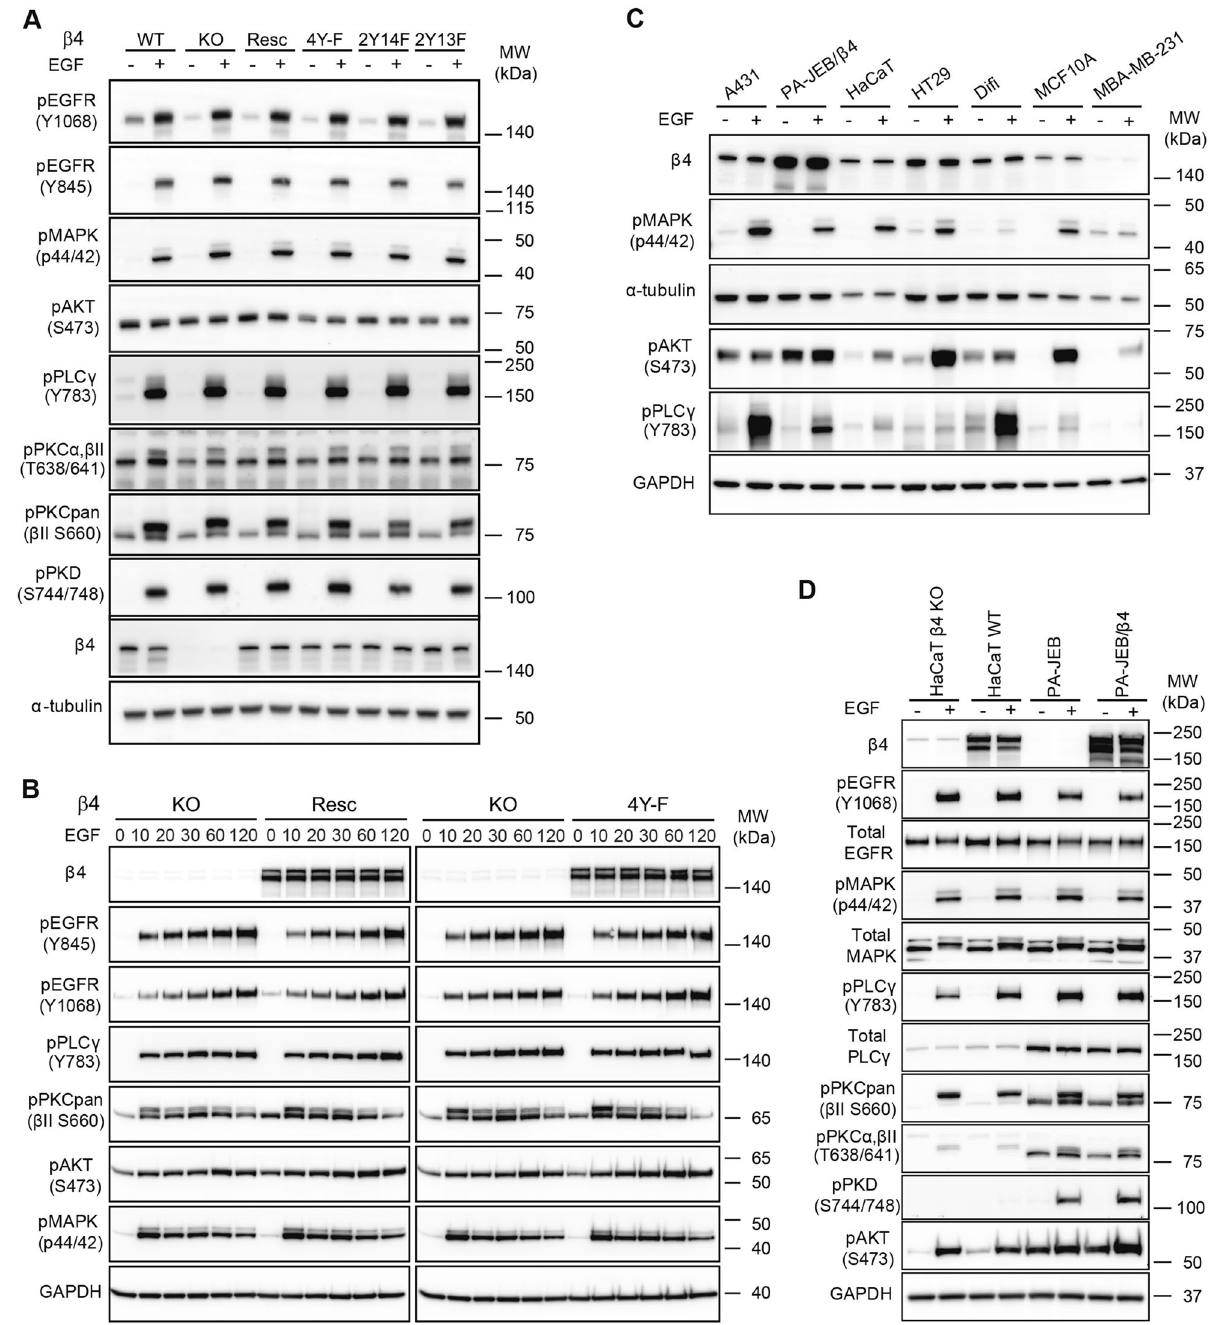
Figure 5. β4 and its tyrosine phosphorylation at the CS does not alter signaling downstream of the EGFR. ( A ) Western blot analyses of WCLs from various WT and β4 mutant A431 cell lines, untreated or treated for 5 min with EGF after 20 h serum starvation, for pEGFR (Y845 and Y1068), pMAPK, pAKT, pPLCγ1, pPKCα, βII (T638/641), pPKCpan (βII S660), pPKD (S744/748), β4 and α-tubulin (loading control). ( B ) Western blot analyses of A431 β4 (Resc), β4 (KO) and β4 (4Y-F) cells untreated or treated for different timepoints (0, 10, 20, 30, 60 and 120 min) with EGF after 20 h serum starvation, for β4, pEGFR (Y845 and Y1068), pPLCγ1 (Y783), pPKCpan (βII S660), pAKT (S473), pMAPK (p44/42) and GAPDH (loading control). ( C ) Western blot analyses of A431, PA-JEB/ β4, HaCaT, HT29, Difi, MCF10A, MDA-MB-231 cells, untreated and treated with EGF for 5 min after 20 h serum starvation, β4, pMAPK (p44/42), pAKT (S473), pPLCγ1 (Y783), α-tubulin and GAPDH (loading controls). ( D ) Western blot analyses of PA-JEB/β4 and HaCaT cells, β4 proficient and deficient, treated with or without EGF for 10 min after 20 h serum starvation, for total β4, pEGFR (Y1068), total EGFR, pMAPK (p44/42), total MAPK, pPLCγ1 (Y783), total pPLCγ1, pPKCpan (βII S660), pPKCα,β II (T638/641), pPKD (S744/748), pAKT(S473) and GAPDH (loading control). Of note, while phosphorylation of PLCγ1 appears reduced in HaCaT β4 KO cells, this reduction was not consistently observed in repeat experiments. Uncropped images of merged chemiluminescent and colorimetric blots obtained with a ChemiDoc imaging system (BioRad) are shown in Suppl. Fig.